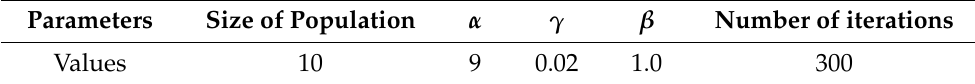
Table 3. Parameter values of Greedy Firefly Algorithm.